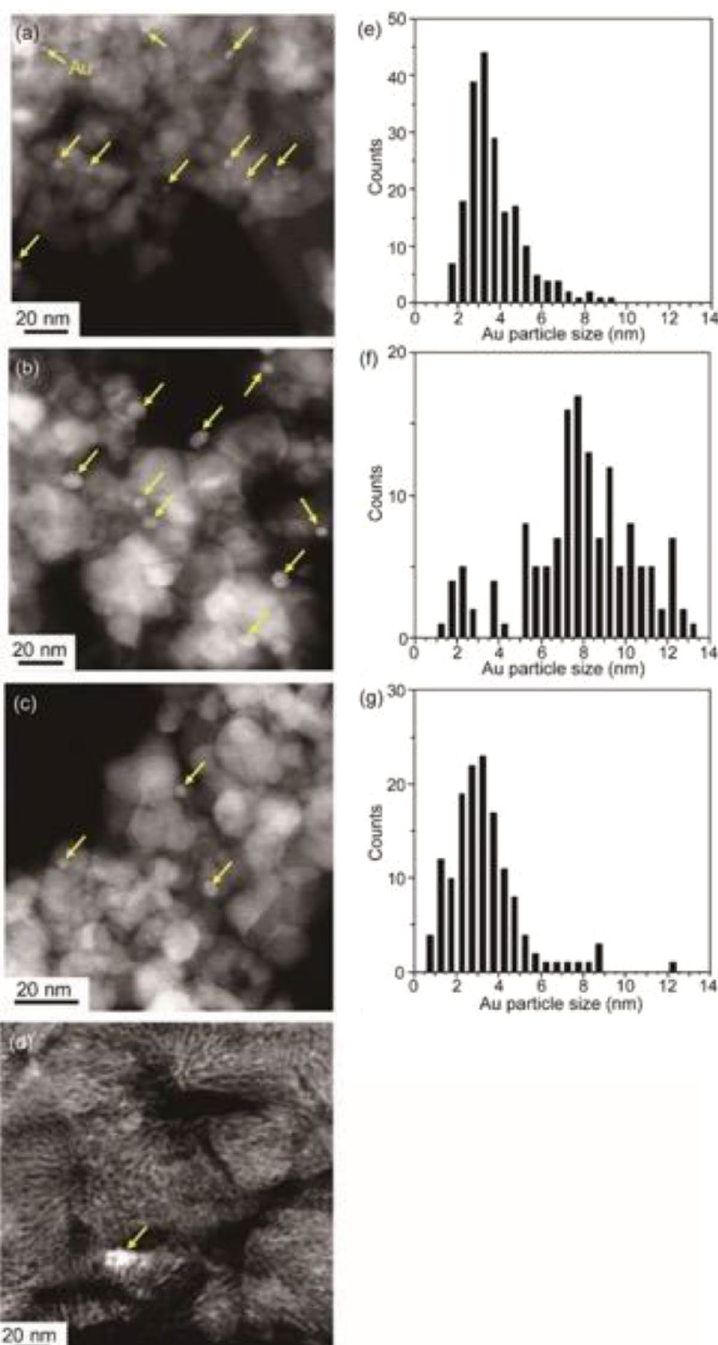
Figure 1. HAADF-STEM images of Au3/TiO 2 ( a ), Au8/TiO 2 ( b ), Au/ZrO 2 ( c ), Au/CeO 2 ( d ) and their size distributions of Au nanoparticles for Au3/TiO 2 ( e ), Au8/TiO 2 ( f ), and Au/ZrO 2 ( g ). Au nanoparticles were observed as brighter spots and yellow arrows indicate the Au nanoparticles. Only small amount of large Au aggregates was found in Au/CeO 2